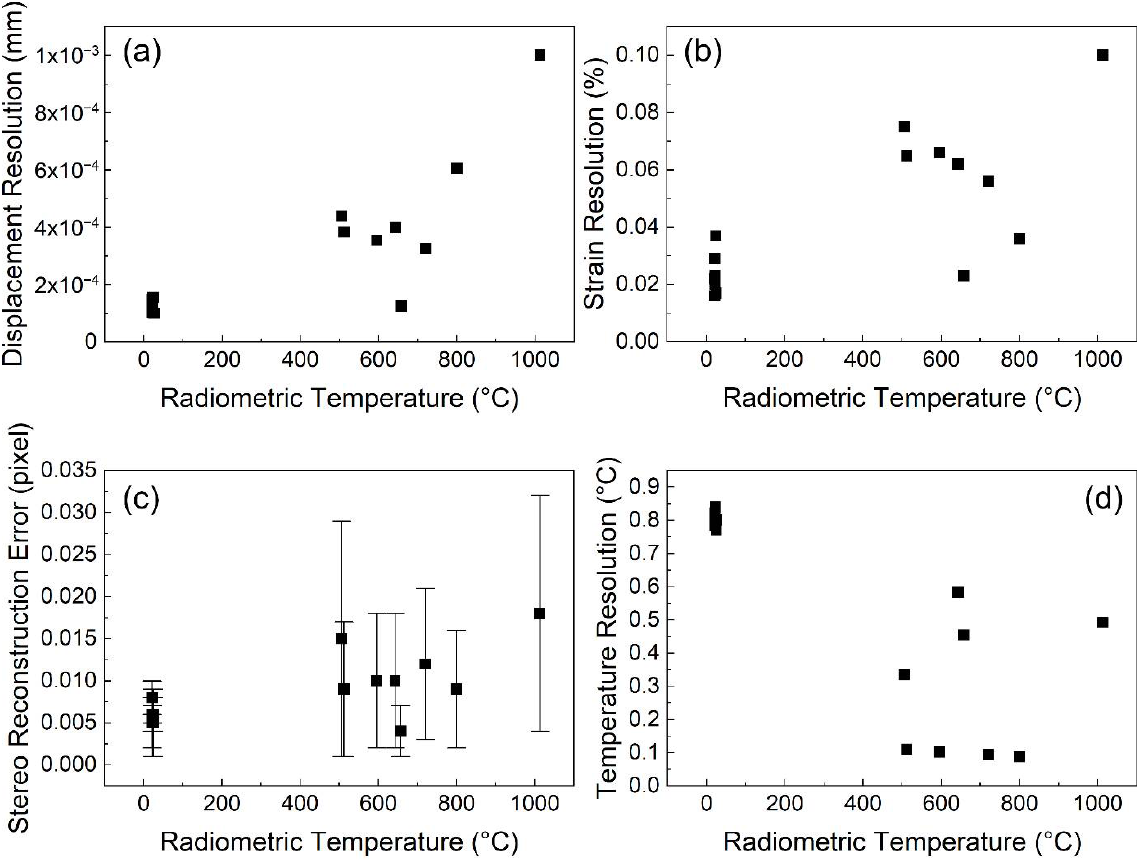
Figure 14. Uncertainties of the full-field quantities-of-interest of the DIC and IRT measurements as a function of radiometric temperature. ( a ) Displacement, ( b ) strain, ( c ) stereo reconstruction error, and ( d ) radiometric temperature. The error bars represent the standard deviation of the stereo reconstruction error throughout the sample gage length.